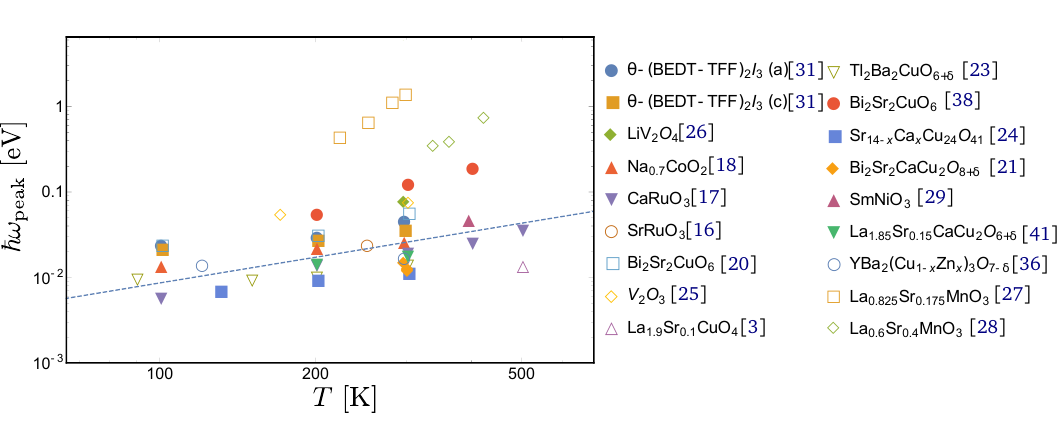
Figure 3: Location of the peak in σ ( ω ) versus temperature in bad metals. The dashed line T shows ħ h ω = k B